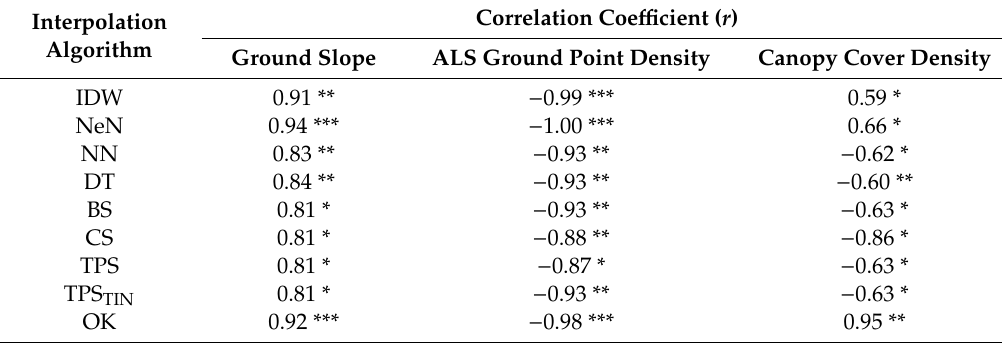
Table 5. Correlation coefficients ( r ) for RMSE values dependent on external factor categories.